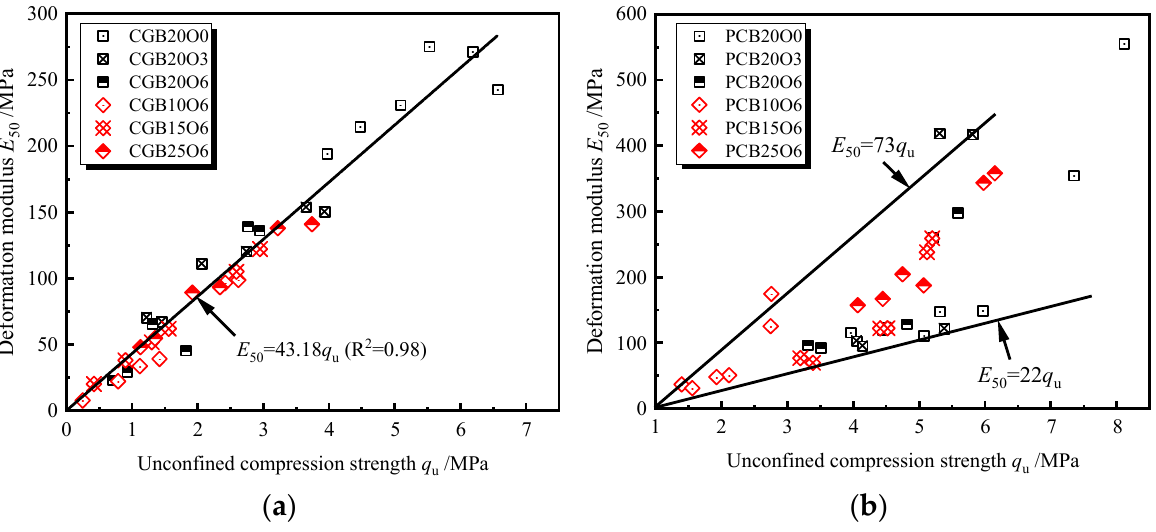
Figure 5. Deformation modulus of CG/PC-stabilized specimens under different conditions. ( a ) CG-treated soils. ( b ) PC-treated soils.